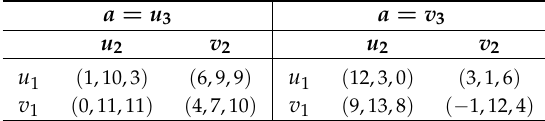
Table 5. The utility matrix of Example 3 for the basic game G 1 for a ∈ A 3 .